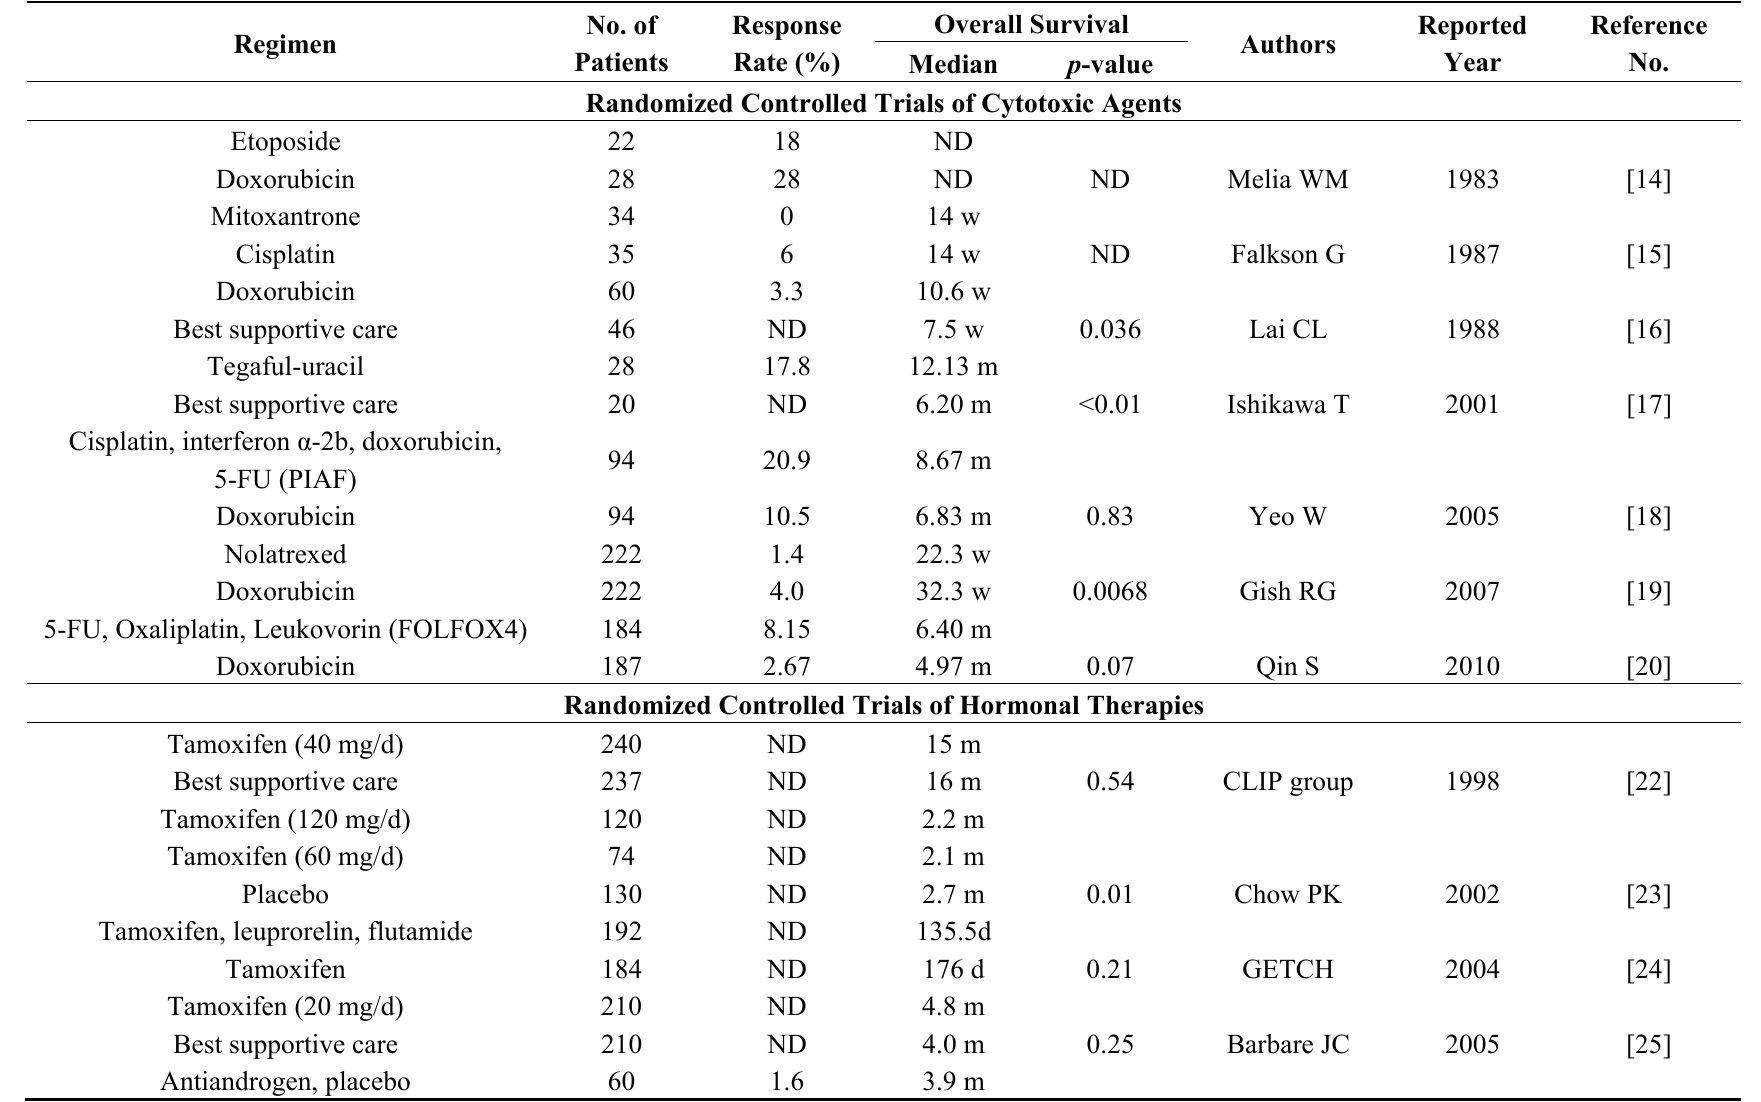
Table 1. Results of main randomized controlled trials of systemic chemotherapy for advanced HCC: Pre